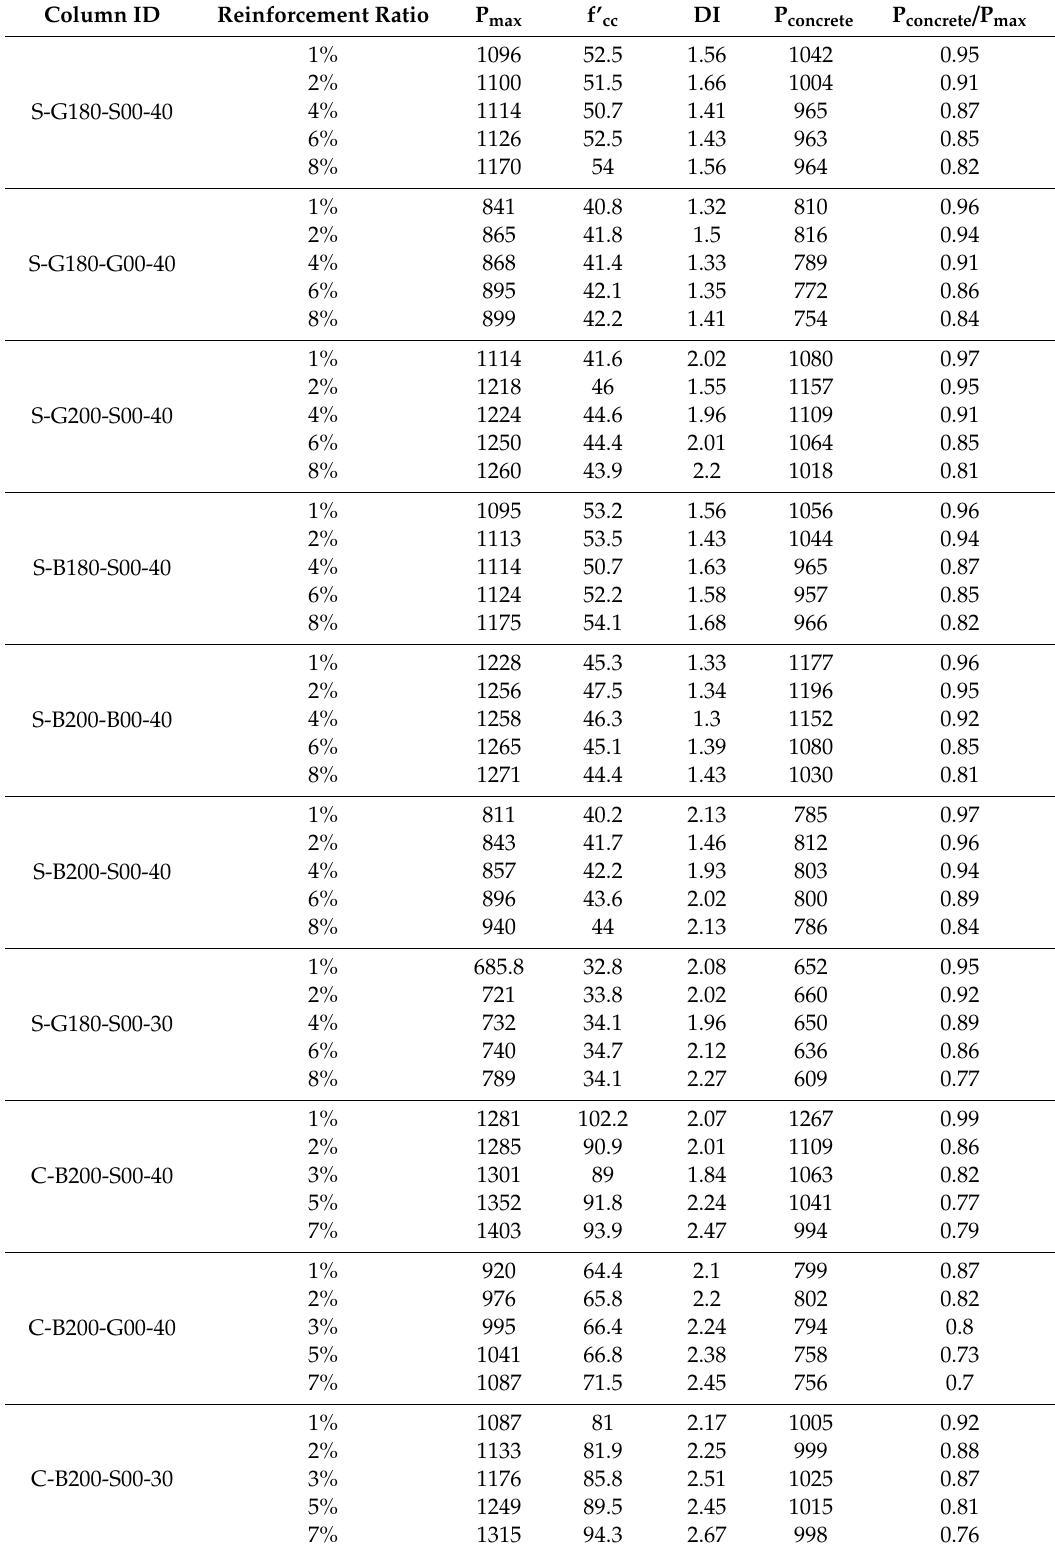
Table 6. Confined concrete strength factors and ductility indices of all concentric columns. Column